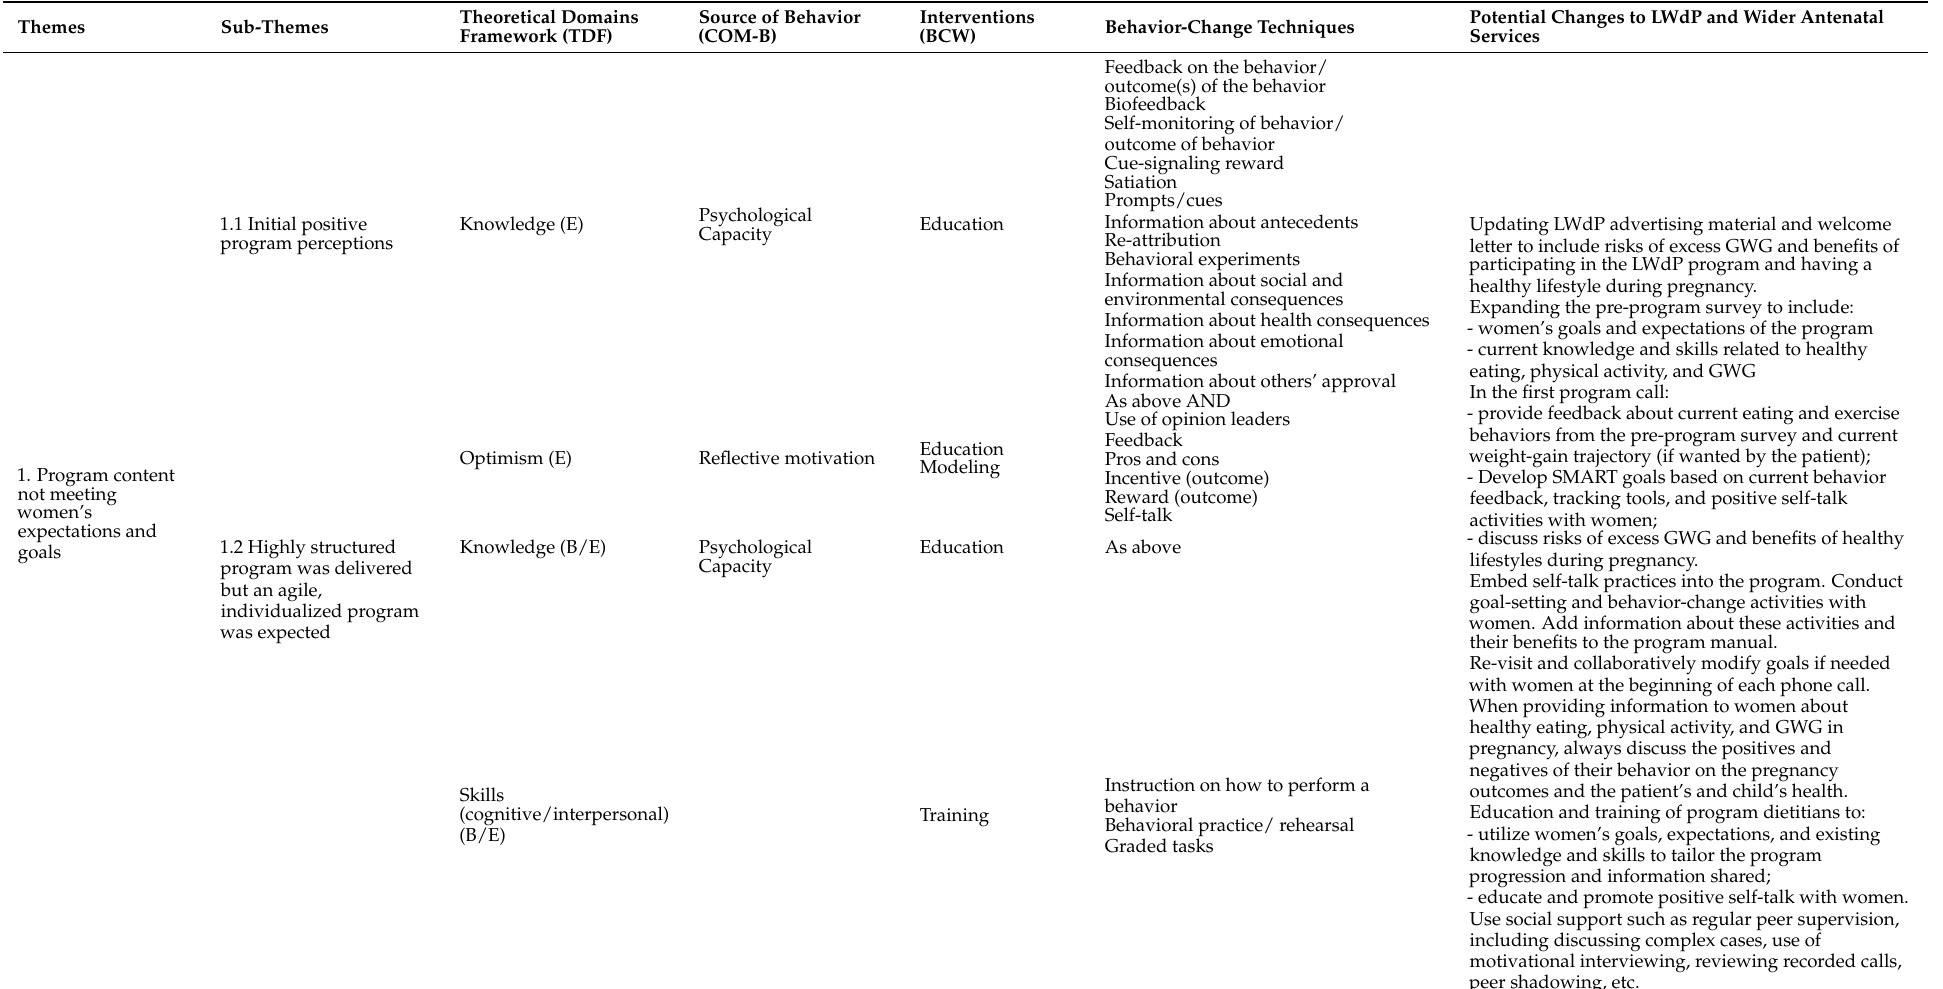
Table 2. Deductive mapping of interview themes utilizing the BCW, COM-B Model, and TDF